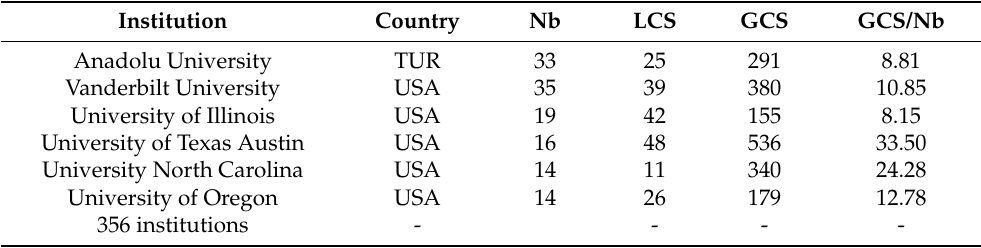
Table 4. Publications by